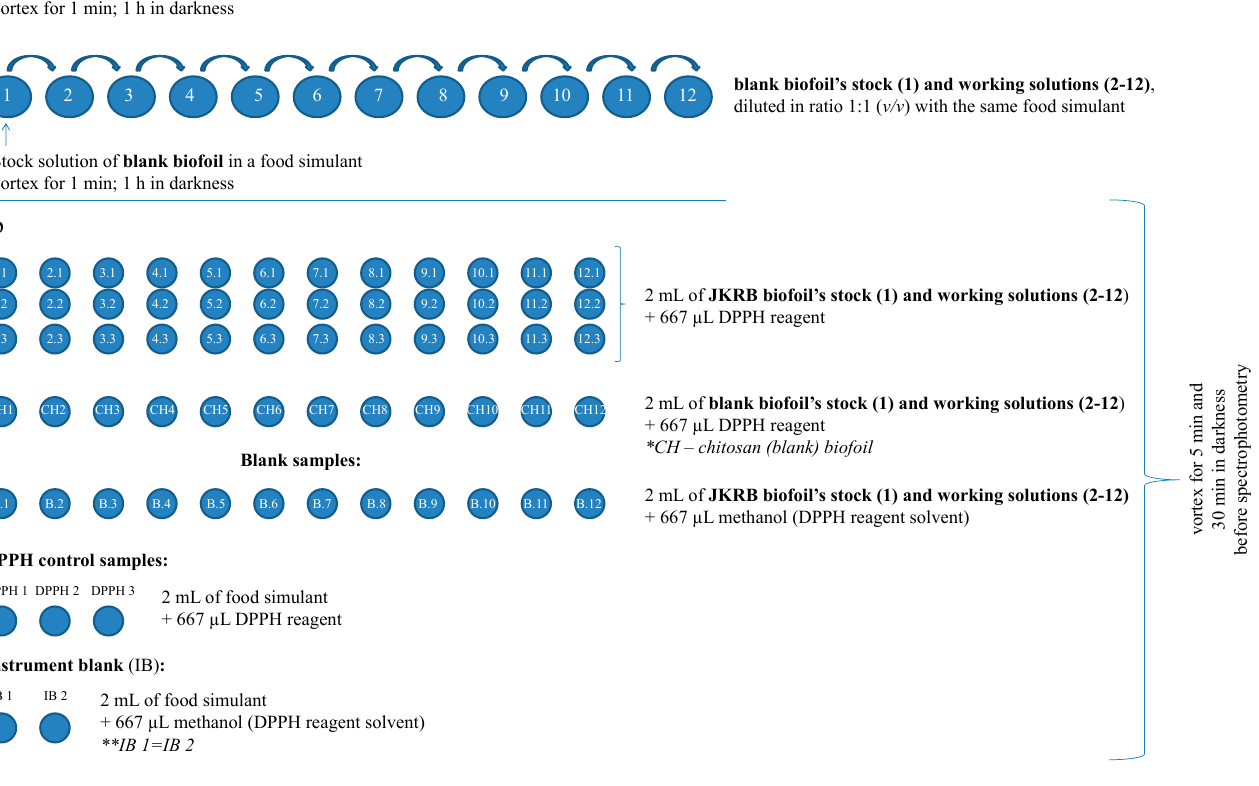
Figure 2. Scheme of the DPPH antioxidant assay: ( a ) preparation of stock and working solutions, ( b ) reactions before spectrophotometric measurements.